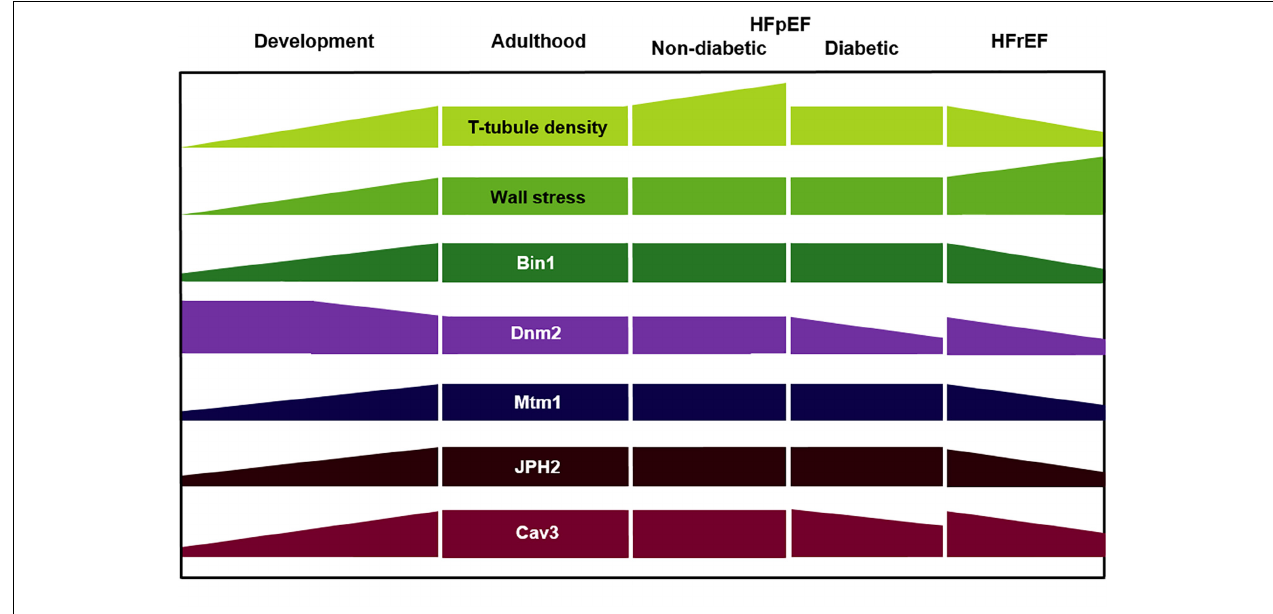
FIGURE 4 | Key regulators of t-tubule structure during development, adulthood, and heart failure of various etiologies. HFpEF, heart failure with preserved ejection fraction; HFrEF, heart failure with reduced ejection fraction; Dnm2, dynamin-2; Mtm1, myotubularin-1; JPH2, junctophilin-2; Cav3, caveolin-3.